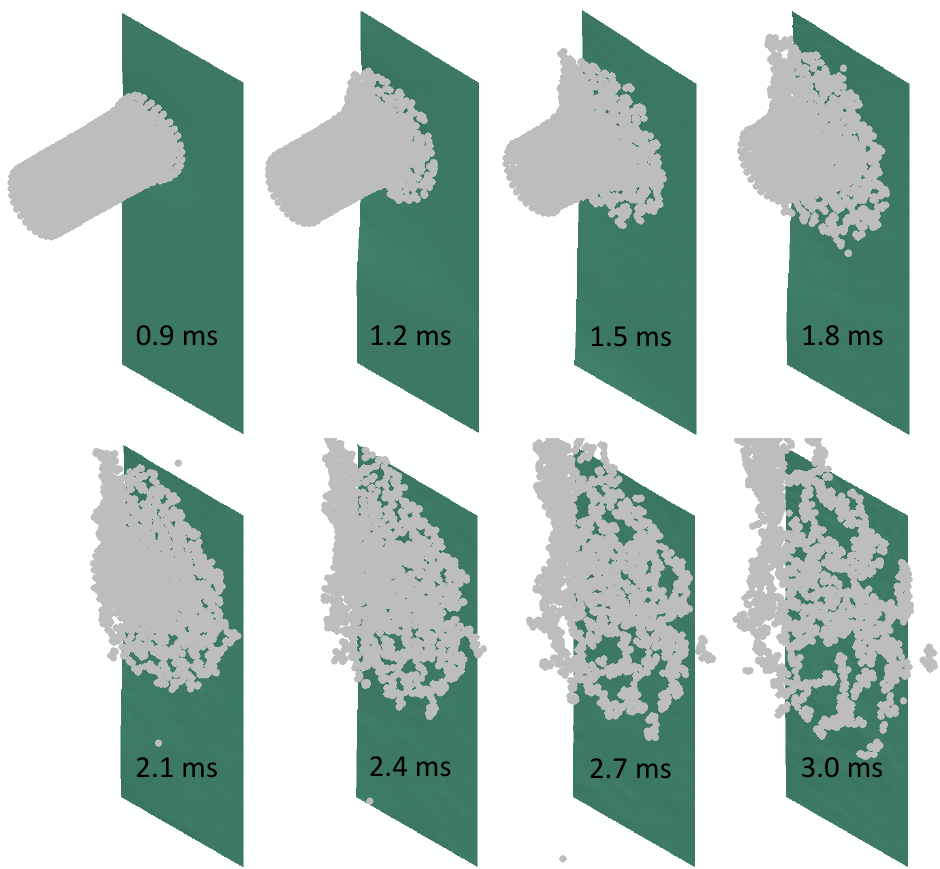
Figure 7. Deformation series of the bird projectile impacting the composite plate with the root and one side edge clamped boundary